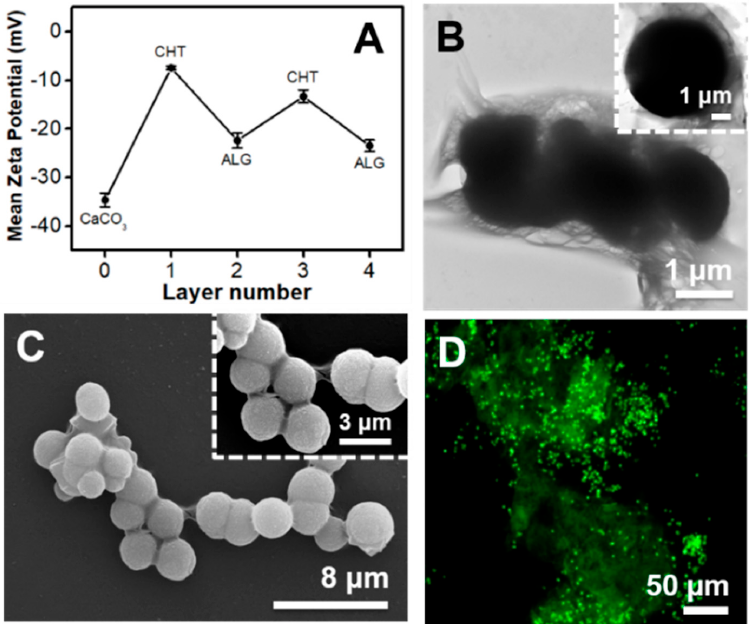
Figure 2. ( A ) Mean ζ -potential as a function of the polysaccharide layer number for the CaCO 3 microparticles coated with alternating CHT and ALG layers. The odd layer numbers correspond to the CHT deposition and the even layer numbers to the ALG deposition. ( B ) TEM, ( C ) SEM and ( D ) FL microscopy micrographs of the core-shell CaCO 3 microparticles after the deposition of two CHT/ALG bilayers. The insets in ( B ) and ( C ) show a higher magnification of the TEM and SEM images, respectively. The inset in ( C ) also shows the high surface roughness of the core-shell microparticles.